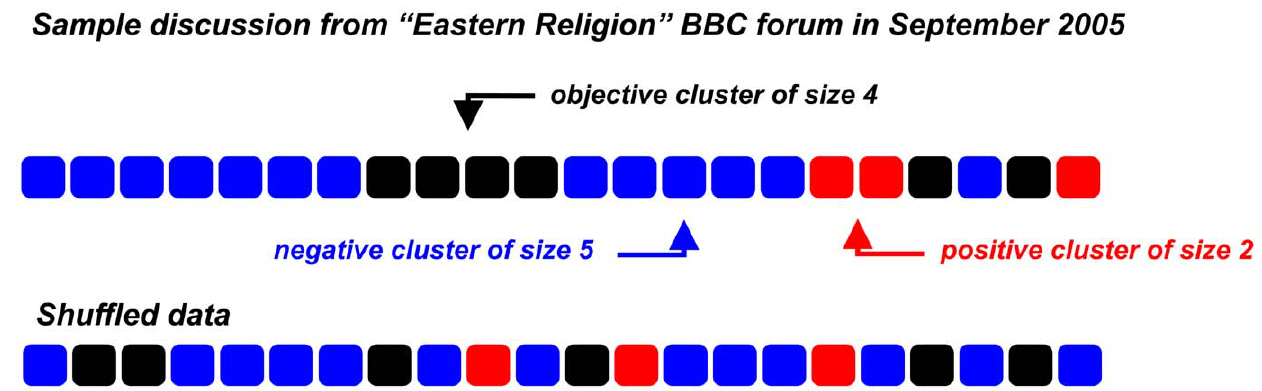
Figure 2. An example of a discussion in the ‘‘Eastern religion’’ BBC forum in September 2005. The original discussion, consisting of 22 posts is shown in the upper row. Each square represents one post: red, blue or black squares indicate that the comment was classified as, respectively, positive, negative or neutral (objective). The bottom row presents shuffled data, i.e., the comments were arranged in a random order. Note the difference between the length of clusters in the original and in the shuffled data.